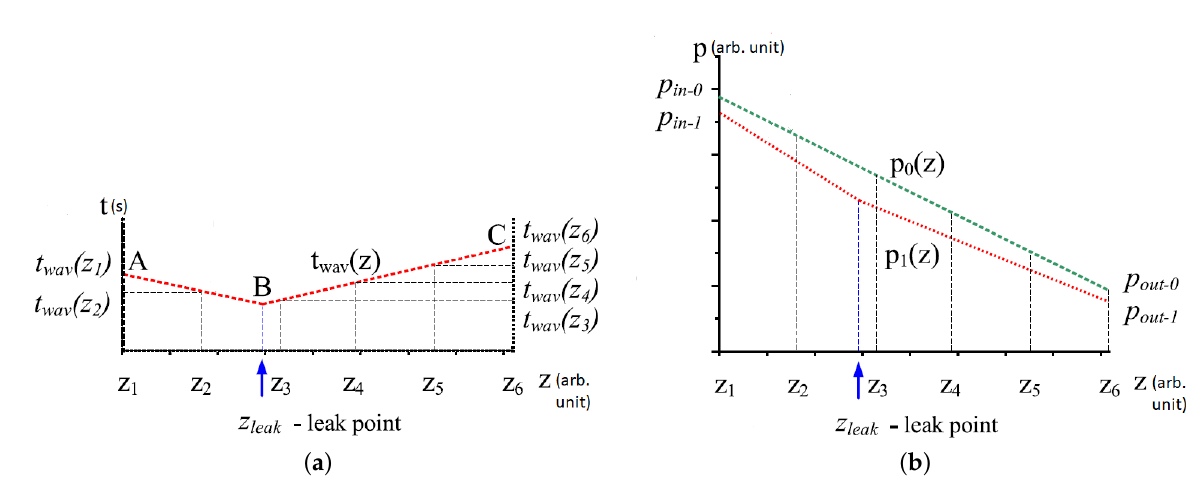
Figure 21. ( a ) Negative pressure wave method analysis. ( b ) Gradient analysis method. Reprinted from Engineering Structures, Volume 113, Ostapkowicz, P. Leak Detection in Liquid transmission Pipelines Using Simplified Pressure Analysis Techniques Employing a Minimum of Standard and Non-Standard Measuring Devices, Page 194–205, Year 2016 with permission from Elsevier